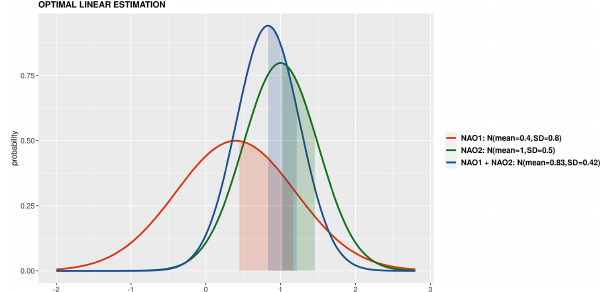
Figure 5. A synthetic example of a PlotPDFsOLE in which two distribution functions are combined.